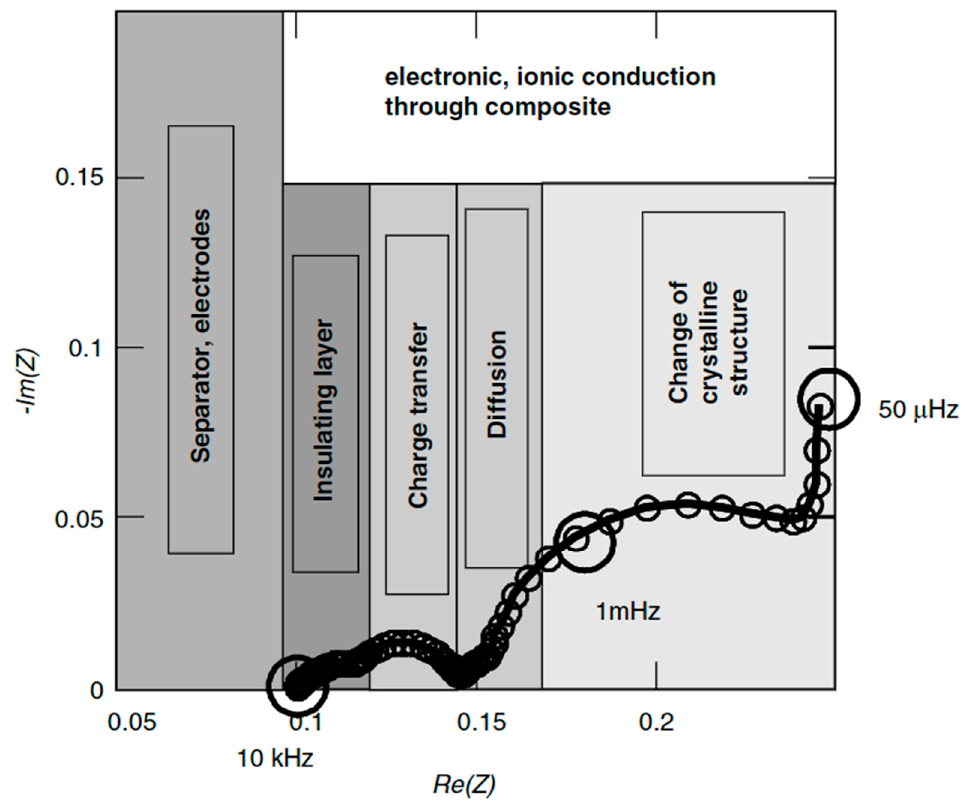
Figure 8. Typical impedance spectra of intercalation material [78]. Reproduced by permission of Wiley.